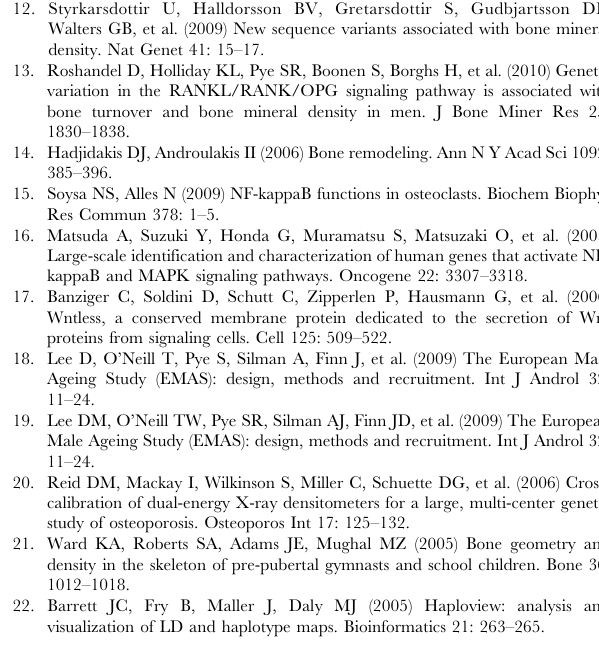
Table S1 Genetic association between MAP3K14 SNPs and BMD a .